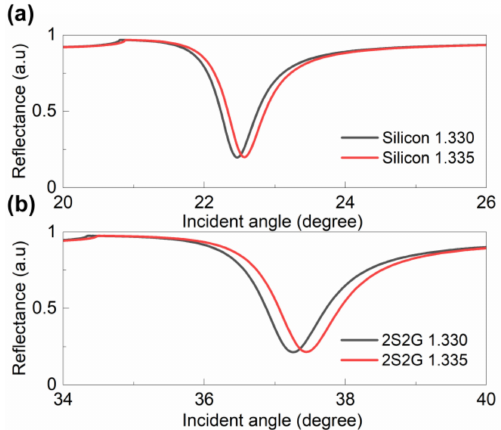
Figure 6. Influence of ( a ) silicon and ( b ) 2S2G glass substrates on the reflectance spectra of the proposed